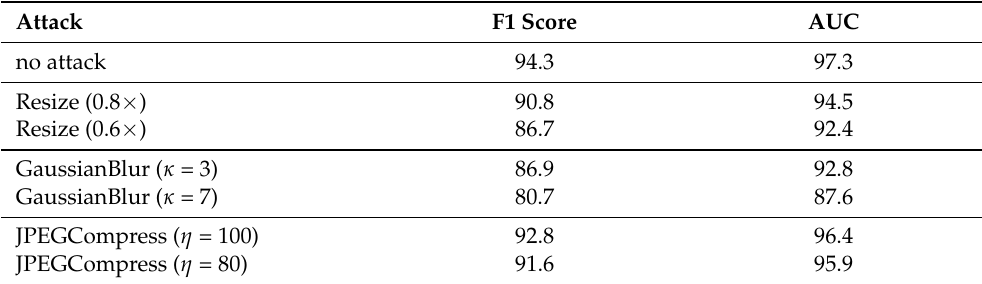
Table 3. The forgery detection results (%) under various attacks on the NIST16 dataset. F1 score and AUC are